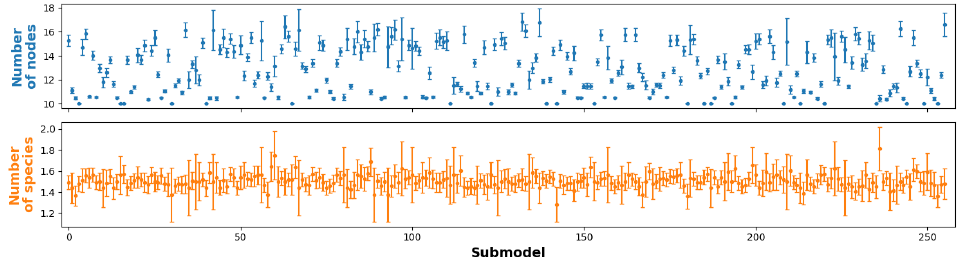
Figure 14: The number of nodes (top) and species (bottom) for all the 256 sub-models. These values are obtained for all N genomes across different generations throughout the training process. The error bars represent the SEM with 95% confidence interval. of species for all classes (corresponding to 256 sub-keys and sub-models) is depicted in Figure 14. Note that although the genomes are relatively small, they perform well and recover the sub-key efficiently (see Figures 9 and